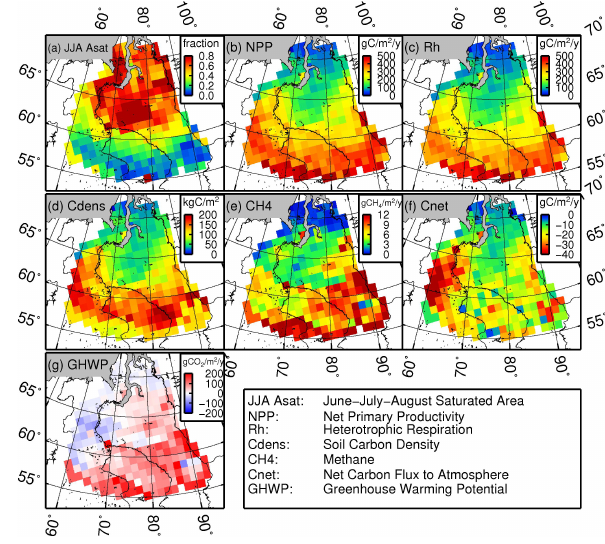
Fig. 5. 2001–2010 annual average simulated states and fluxes, per unit wetland